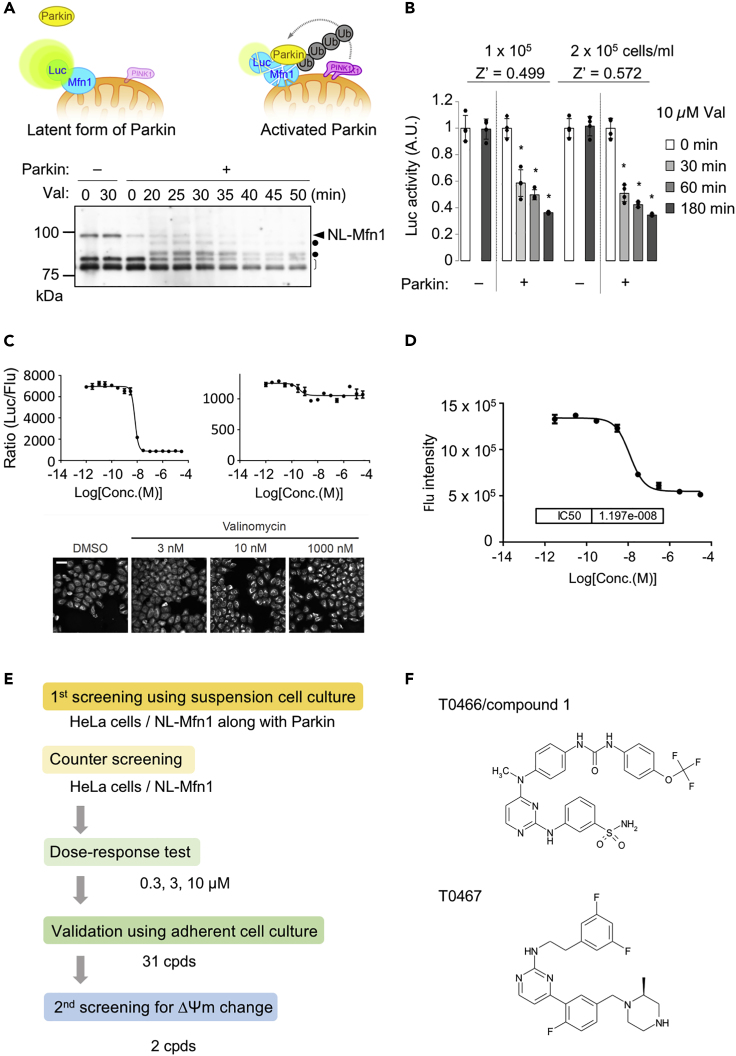
Development of the NL-Mfn1 Screening System(A) (Top) Schema of the NL-Mfn1 reporter assay to monitor Parkin activity. (Bottom) Time course analysis of NL-Mfn1 degradation after PINK1 activation by valinomycin (Val) treatment. Lysate of HeLa cells expressing NL-Mfn1 in the presence or absence of Parkin treated with 10 μM Val were analyzed by western blot with anti-Mfn1. NL-Mfn1 (arrowhead), endogenous Mfn1 (open bracket) and ubiquitinated Mfn1 (dots) are shown.(B) Validation of the NL-Mfn1 reporter assay using Val. NL activity was normalized using fluorescence signals monitoring cell viability and density in 96-well plates. The value of non-treatment (0 min) for each cell line was set as 1. Z′-factors for the given cell densities are also shown. Data are presented as mean ± SEM from four independent samples. ∗p < 0.01 by one-way ANOVA with Tukey-Kramer test.(C) Val dose response in the NL-Mfn1 reporter assay. (Top) Graphs (mean ± SD, n = 2 independent samples) representing NL activity normalized using the fluorescence signals of HeLa cells expressing NL-Mfn1 in the presence (left) or absence (right) of Parkin and treated with the indicated doses of Val. (Bottom) PINK1 accumulation in reporter cells with Parkin under the same conditions. Scale bar, 50 μm.(D) ΔΨm assay validation using MitoTracker Red. Cells were treated as in (C). The IC50 was 1.197 × 10−8 M, at which the NL-Mfn1 reporter fully detected Parkin activation (see graphs in [C]). Data are presented as mean ± SD from eight independent samples.(E) Screening flow. See Methods for details.(F) Chemical structure of T0466 and T0467.See also Figure S1.